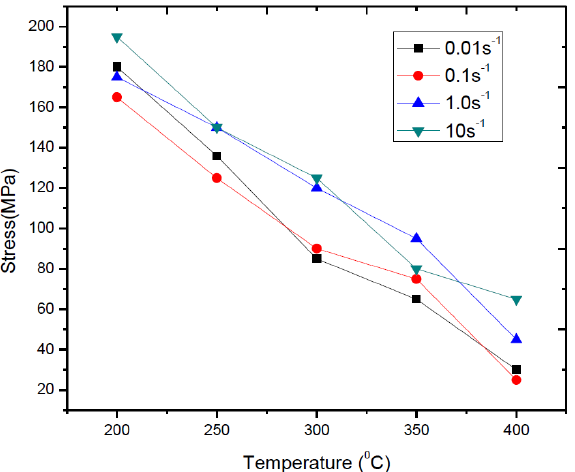
Figure 2: Effect of testing temperature (200–400 ∘ C) and strain rate (0.01–10 s –1 ) on the peak stress Al6063/6 wt.% steel p composites.